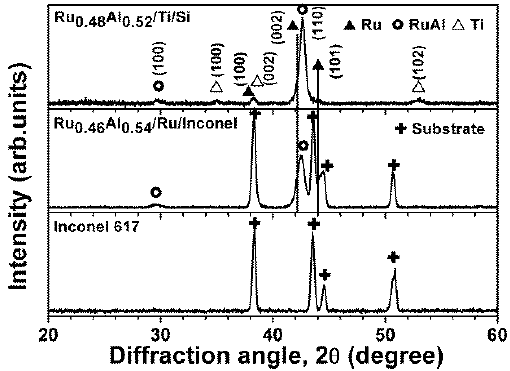
Figure 3. Bragg–Brentano scan of XRD patterns from the Inconel substrate, Ru 0.46 Al 0.54 /Ru/Inconel, and Ru 0.48 Al 0.52 /Ti/Si samples.